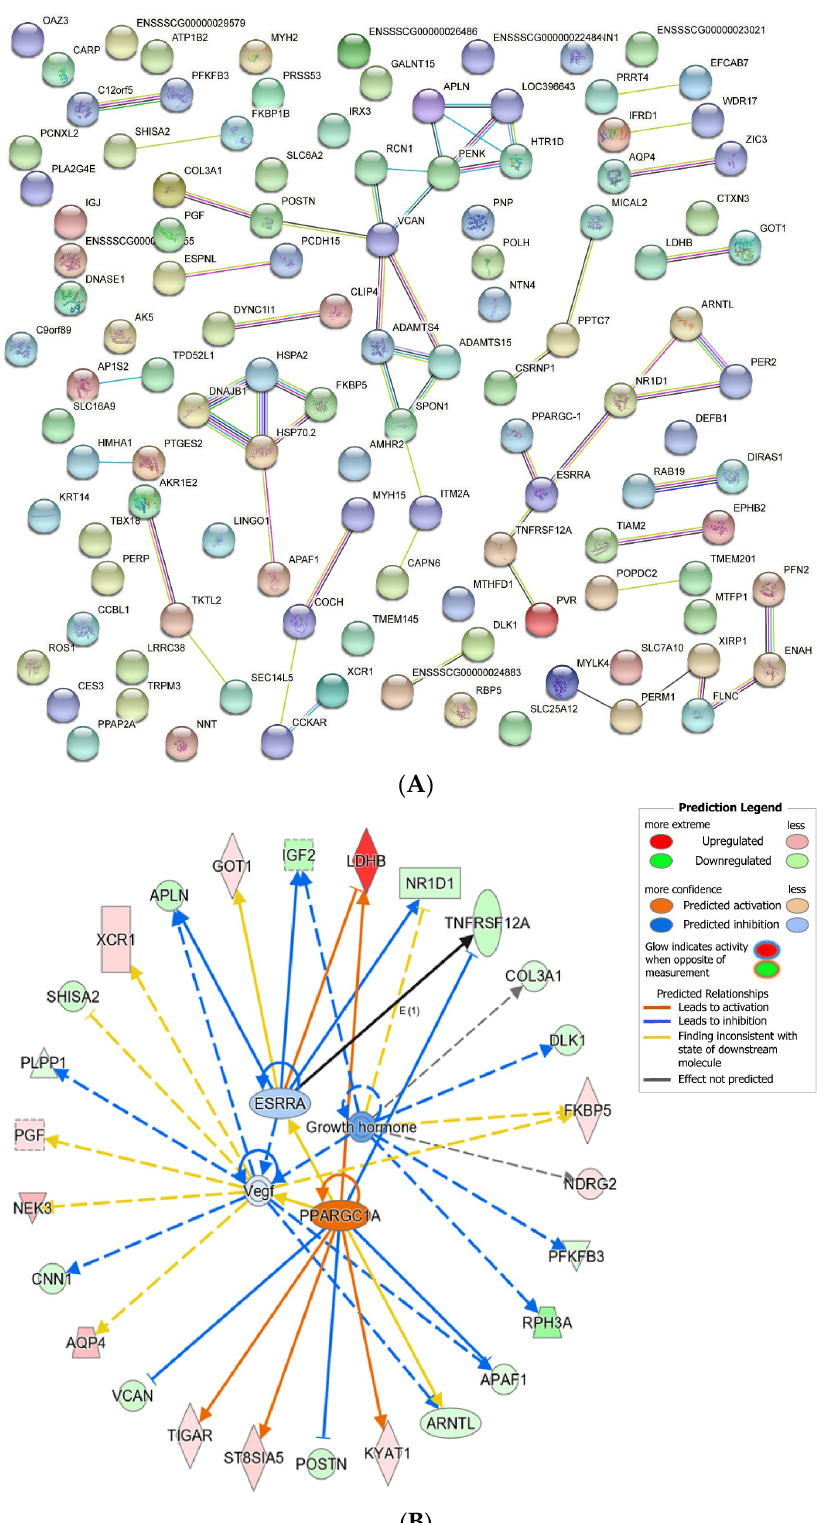
Figure 3. Interaction network for DE mRNAs. ( A ) Protein-protein interaction of DE mRNAs. The network nodes are proteins and the edges represent the predicted functional associations. ( B ) The gene interaction network of DE mRNAs by the ingenuity pathway analysis (IPA). The solid line represents direct interaction; dotted line represents indirect interaction.